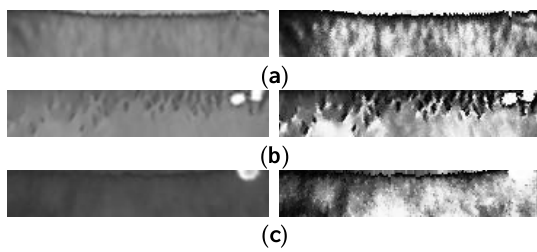
Figure 17. An example of the filtered image. ( a ) Gaussian filtering of Figure 6a, ( b ) equalization histogram of Figure 6a, ( c ) Gaussian filtering of Figure 6b, ( d ) equalization histogram of Figure 6b, ( e ) Gaussian filtering of Figure 6c, ( f ) equalization histogram of Figure